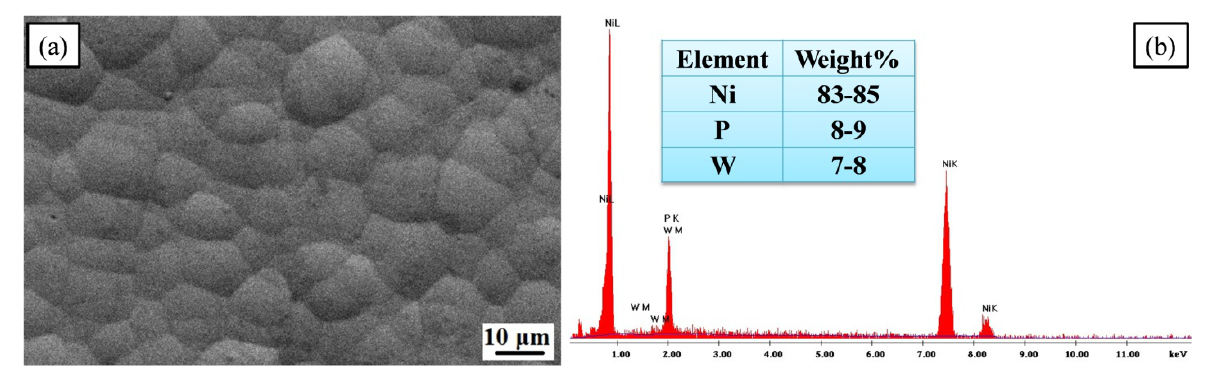
Figure 8. (a) SEM and (b) EDS analysis of Ni-P-W coating at its initial combination of parameters (A 1 B 3 C 3 )